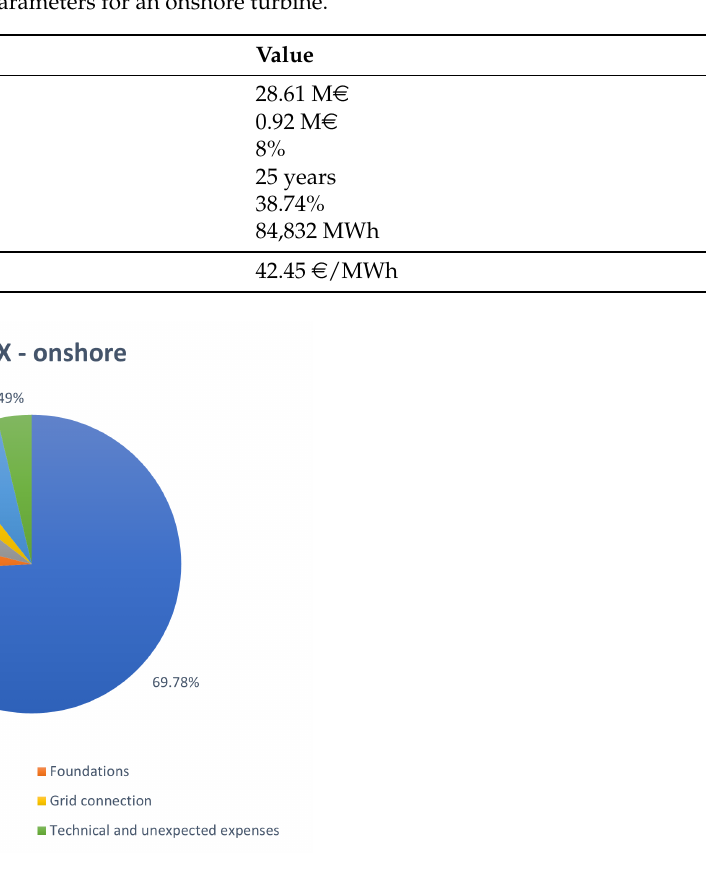
Figure 18. Onshore wind farm CAPEX